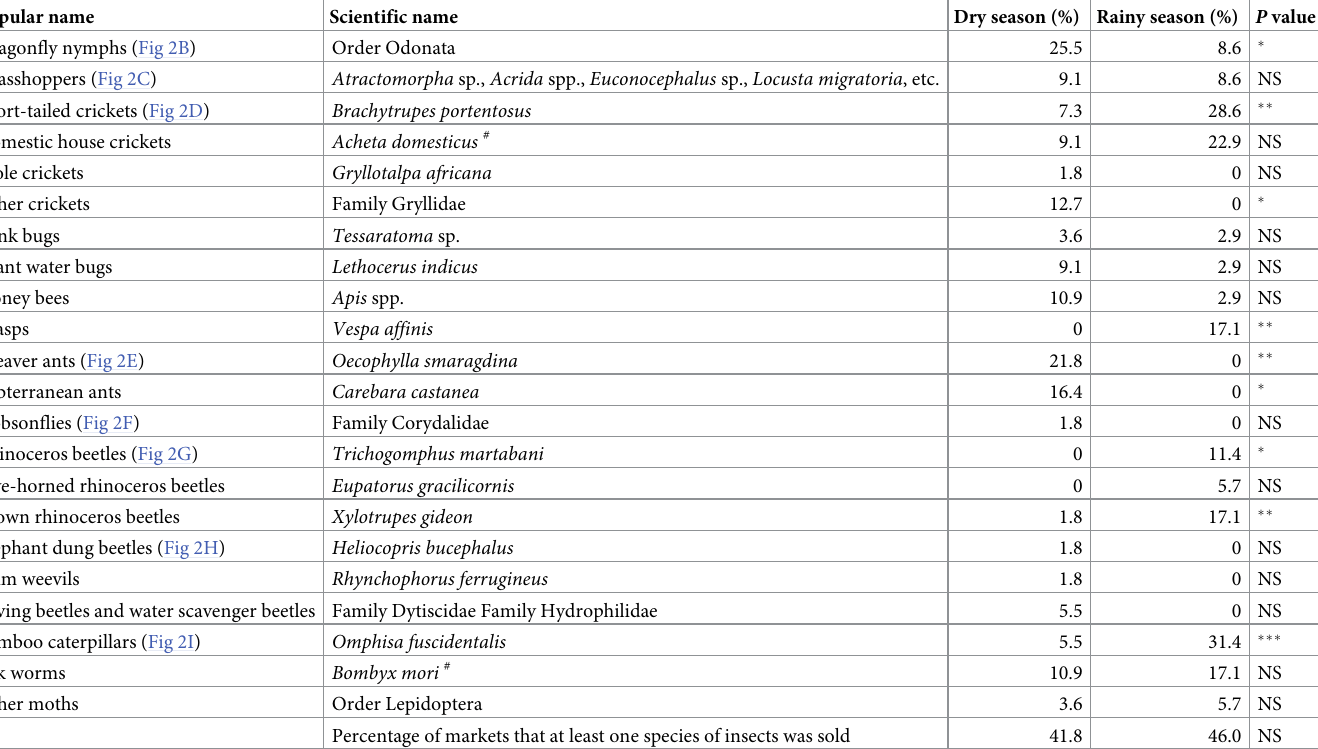
Table 1. The percentages of food markets selling each group of insects in dry and rainy seasons